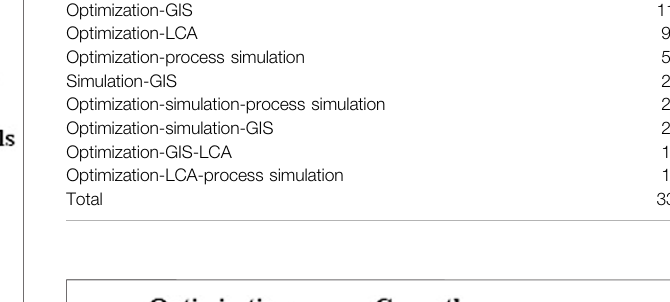
TABLE 5 | Overview of the number of studies combining solution approach with another computational model. Optimization-GIS